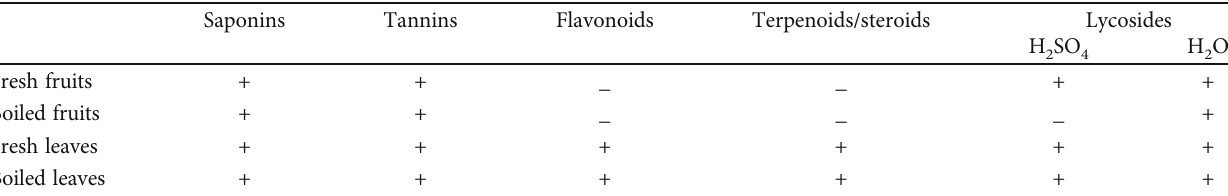
Table 4: Phytochemical screening of Solanum torvum fruit and